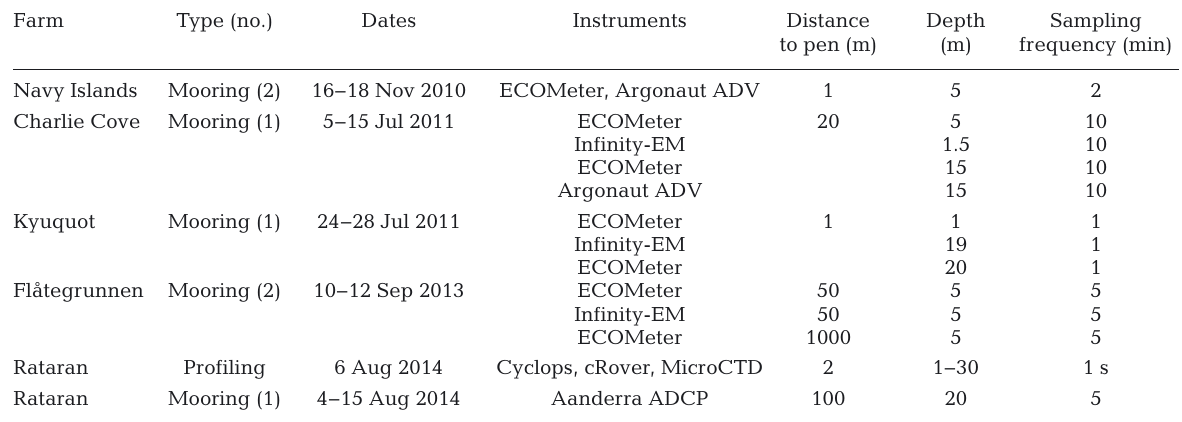
Table 1. Deployment types at each location included fixed depth instrument moorings (number of mooring sites indicated) or water-column profiling. Details of particle and current meter sensor deployments at the 5 fish farms (see Fig.